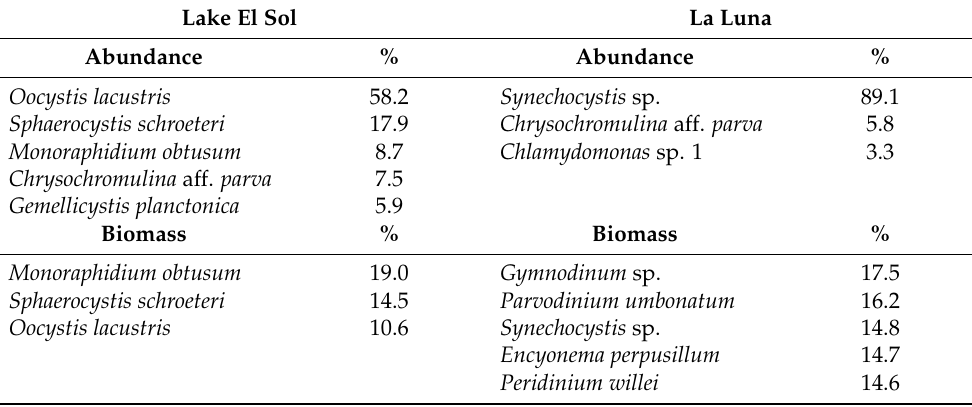
Table 4. Dominant species in abundance (>1%) and biomass (>10%) in Lakes El Sol and La